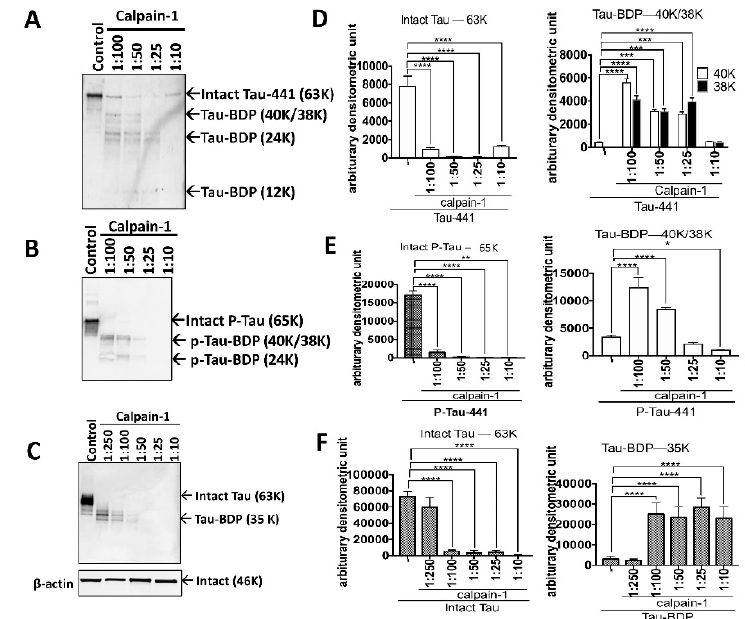
Figure 2. Identification of high molecular weight calpain-mediated tau proteolytic peptides by immunoblotting. ( A ) (recombinant tau), ( B ) (recombinant phospho-tau), and ( C ) (mouse brain lysate) are Western blots displaying intact tau and high-molecular-weight tau breakdown products (HMW-tau-BDPs) treated with di ff erent calpain-1 concentrations (1:100, 1:50, 1:25, and 1:10). ( D – F ) are quantification graphs of the intact tau (63–65K) and tau-BDP (40K / 38K) from tau, p-tau, and mouse brain lysate, respectively. Total tau antibody (DA9, amino acids (a.a.): 102–145) was used. Densitometric quantification of the intact and tau-BDP was performed using image-J. Data are presented as ± standard error of the mean (SEM) for n = 3. Statistical analysis was performed with one-way analysis of variance (ANOVA). For multiple comparisons, one-way ANOVA followed by the Bonferroni’s post-hoc test was performed. * p < 0.05, ** p < 0.01, *** p < 0.001, **** p < 0.0001, and ns: non-significant.